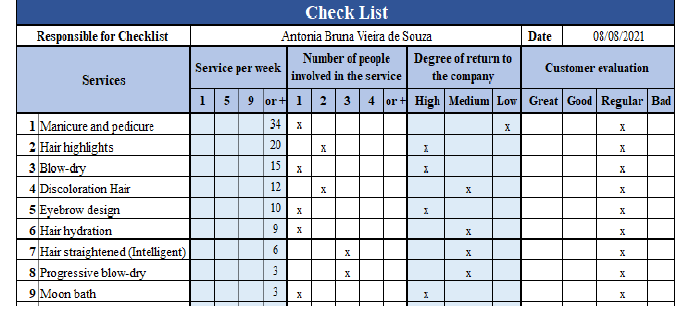
Figure 3: List of services, demand, and customer evaluation. Source: Authors, (2021).